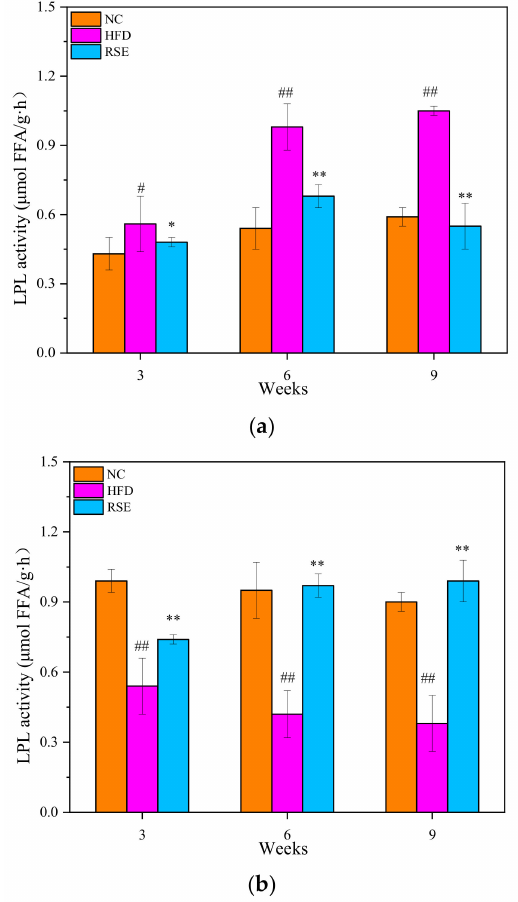
Figure 3. Effect of RSE on the LPL activity in epididymal adipose ( a ) and skeletal muscle ( b ). Data are expressed as the mean ± SEM. # p < 0.05 and ## p < 0.01 for NC p. HFD; * p < 0.05 and ** p < 0.01 for RSE vs. HFD. Group abbreviations: refer to Figure 2